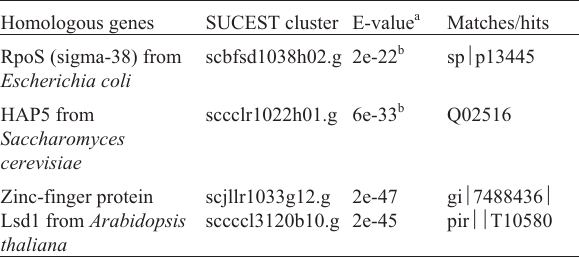
Table X - Oxidative stress regulators. Homologous